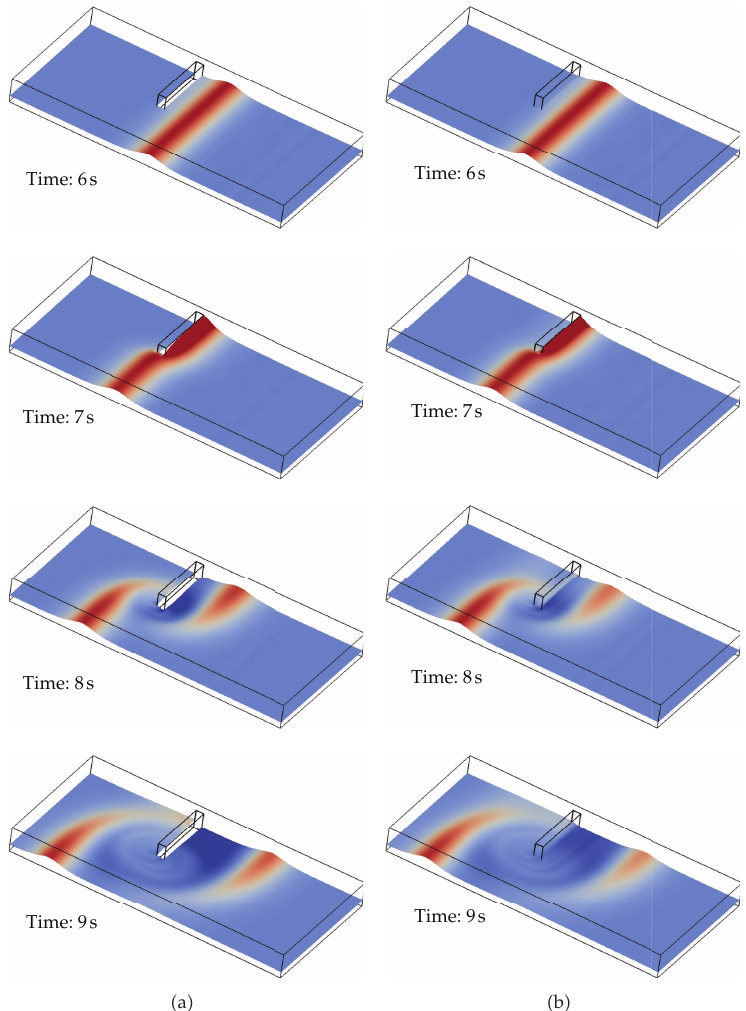
Figure 3: Snapshots at di ff erent times of the solitary wave interacting with the impermeable structure (cid:2) a (cid:3) and the porous one (cid:2) b (cid:3)